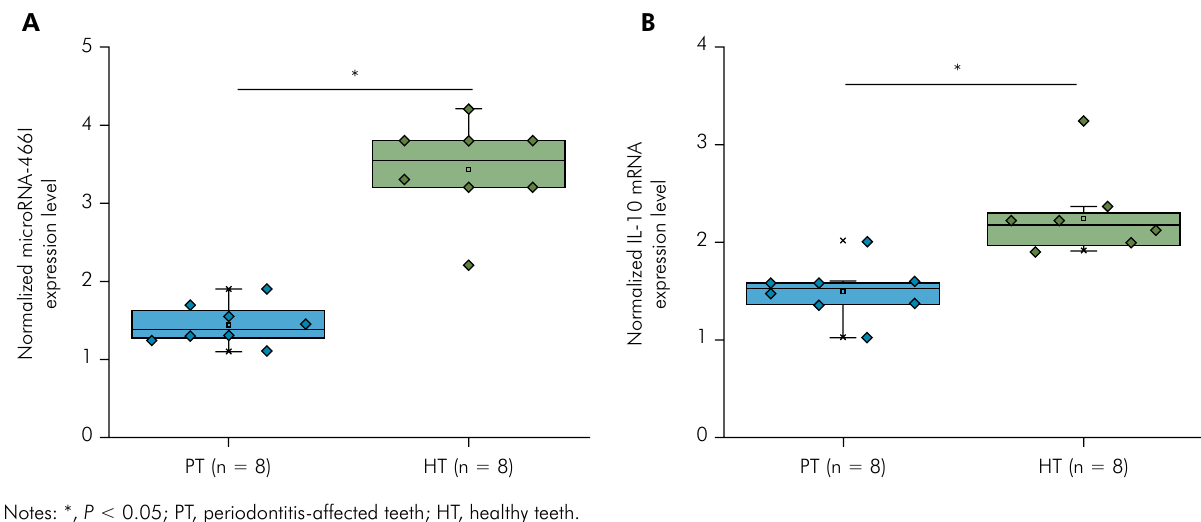
Figure 1. Expression of microRNA-466l (a) and IL-10 mRNA (b) in PDLSCs derived from periodontitis-affected teeth or healthy teeth. This figure shows thet expression of microRNA-466l (a) and IL-10 mRNA (b) in PDLSCs derived from periodontitis-affected teeth and health